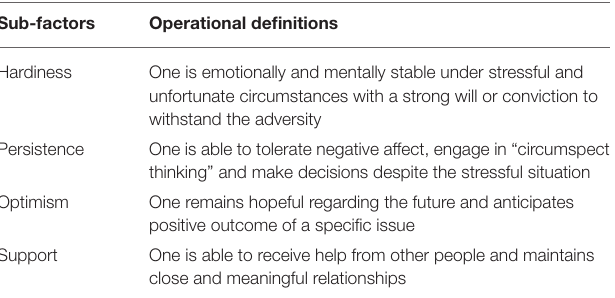
TABLE 7 | Operational definitions of the sub-factors of the Korean version of Connor–Davidson Resilience Scale (Baek et al., 2010).